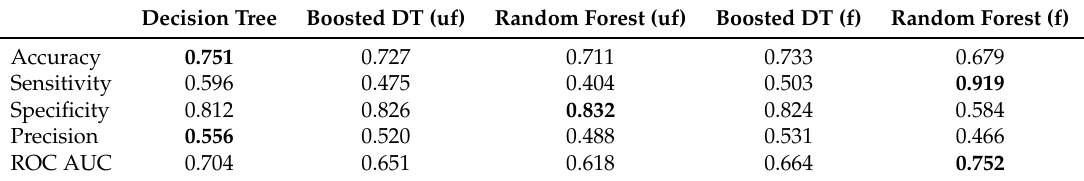
Table 2. Statistical measures of the performance of the different machine learning methods, separated by models either unfitted (uf) or fitted (f) following an optimal receiver operating characteristic (ROC)